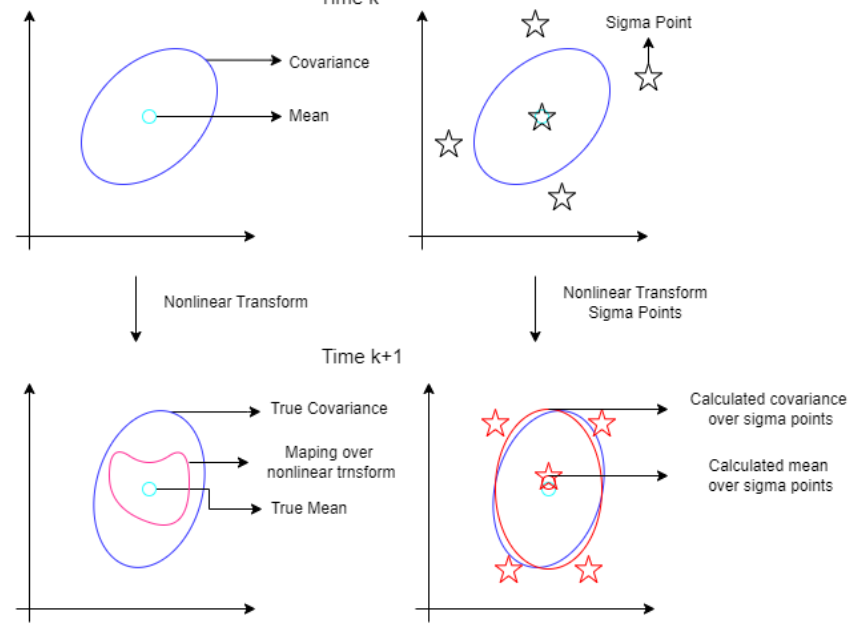
Figure 2. Unscented transform process: selecting sigma points and calculating posterior covariance and mean after